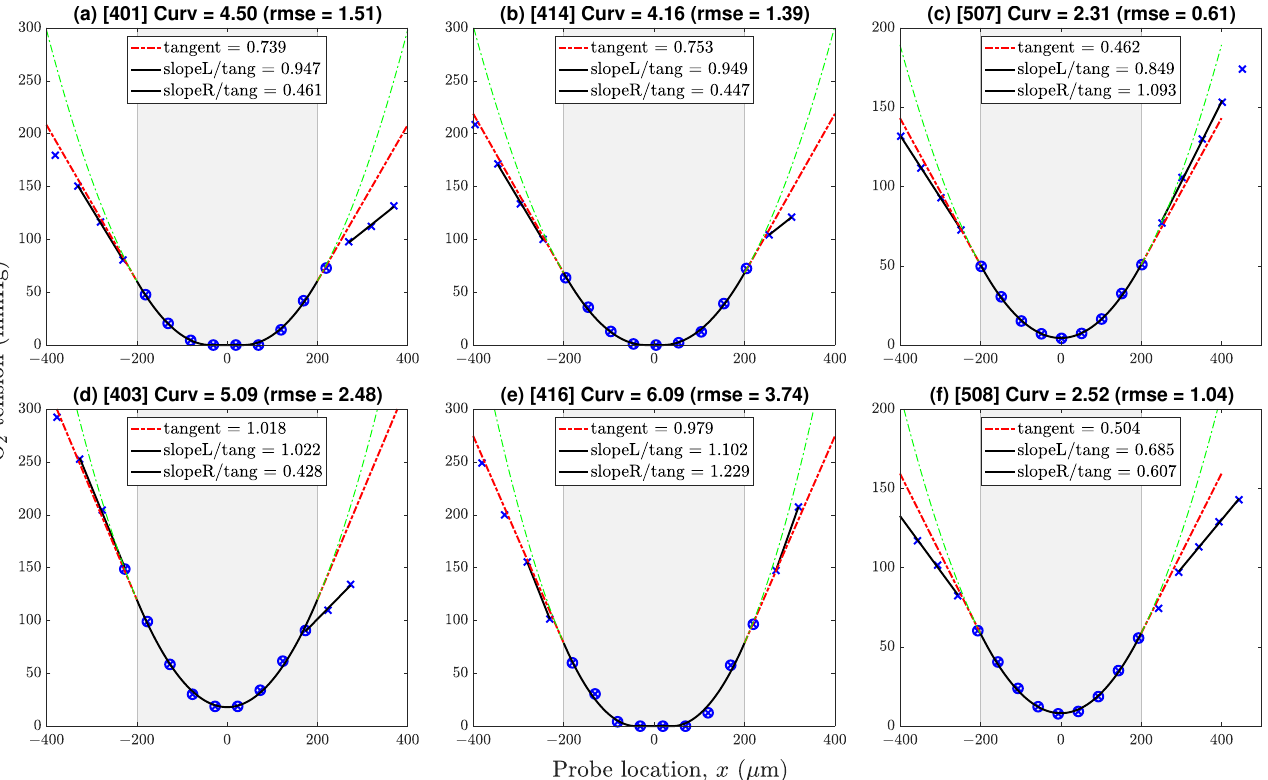
Figure 6. Representative O 2 pressure profiles drawn from datasets v4 (first two columns) and v5 (third column). Profiles ( a , b , d , f ) show a gradient discontinuity at the lower boundary; profiles ( c , e ) do not. Negative/positive locations correspond to points lying above/below the x = 0 line of symmetry. Key: × = sample values; ⊗ = samples selected for 9-point in-tissue curve-fit (parabola or paracosh); dashed-green = extrapolation of parabola/paracosh curve into fluid layers above (left) and below (right) the tissue–fluid interface; dashed-red = tangent to curve at boundary with slope ( ∂ P / ∂ x ) | x = L [mmHg/ µ m]; solid-black linear segments identify linear pressure trends in proximal fluid layer; ‘Curv’ = 10 3 × curvature = 10 3 × ( 2 a ) [mmHg/ µ m 2 ]. Gradient ratios ‘slopeL/tang’, ‘slopeR/tang’ give estimates for above-slice, below-slice ( K t / K f ) Krogh ratios; ratios exceeding cutoff value 0.725 are